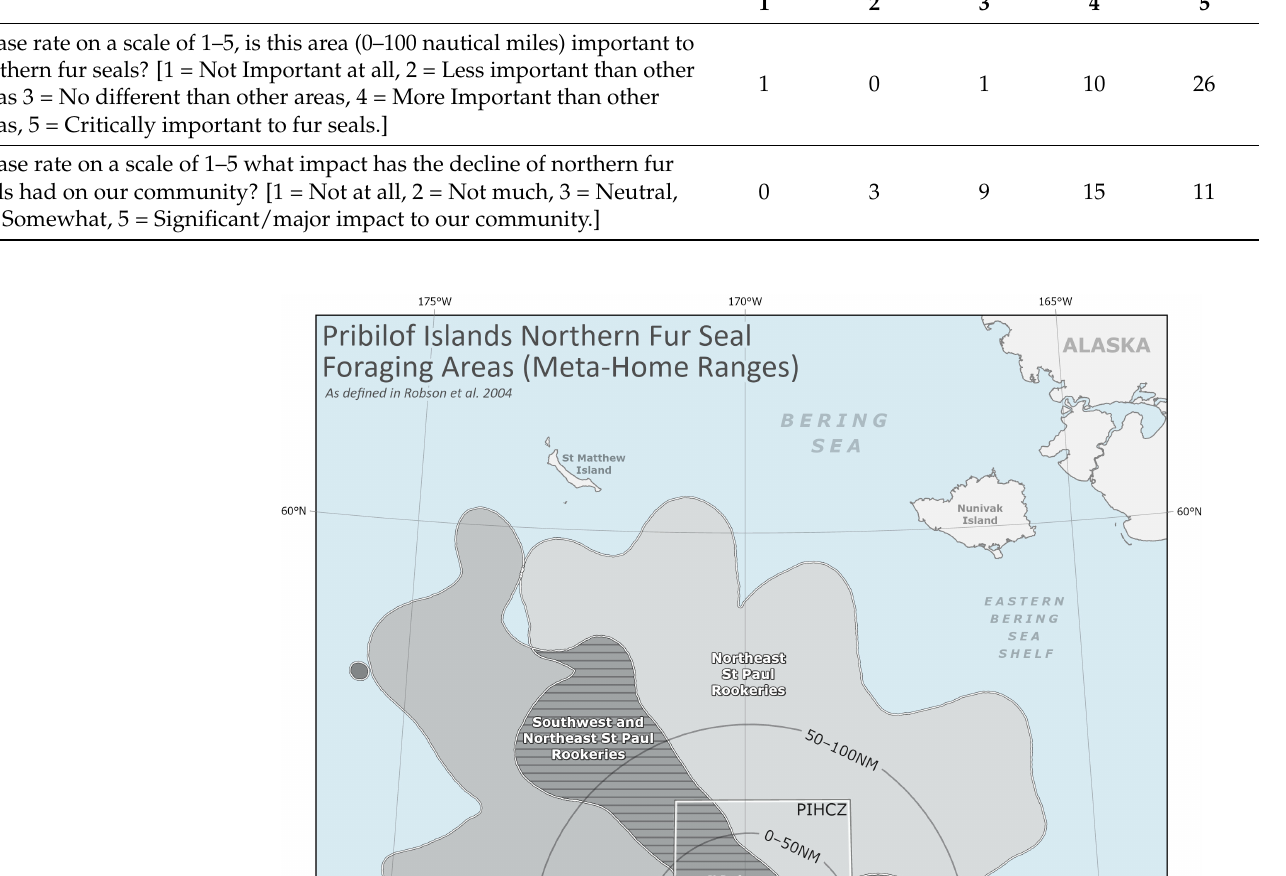
Table A3. Likert questions and response frequency from community surveys.